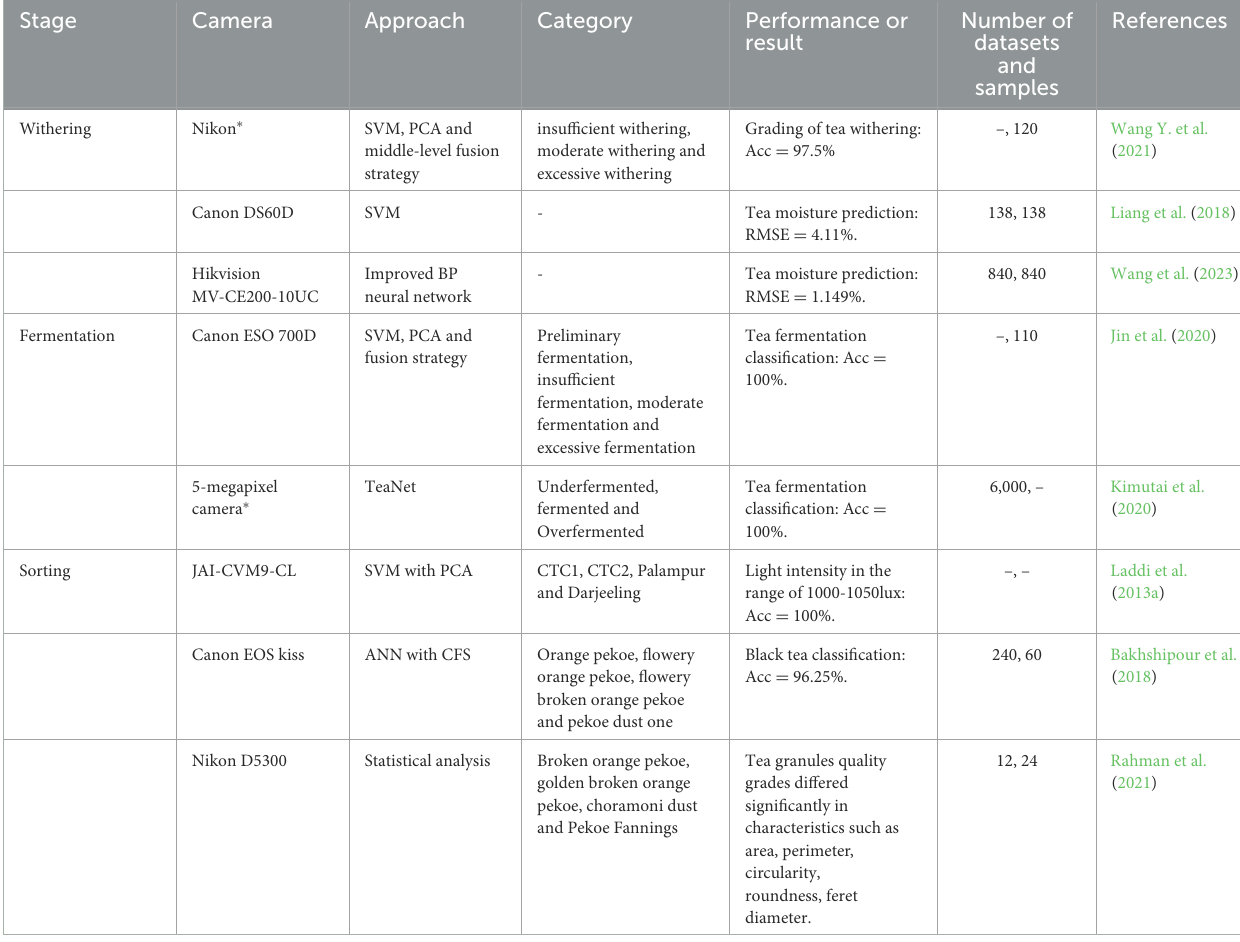
TABLE 4 Summary of the application of computer vision and machine learning in tea production and processing.